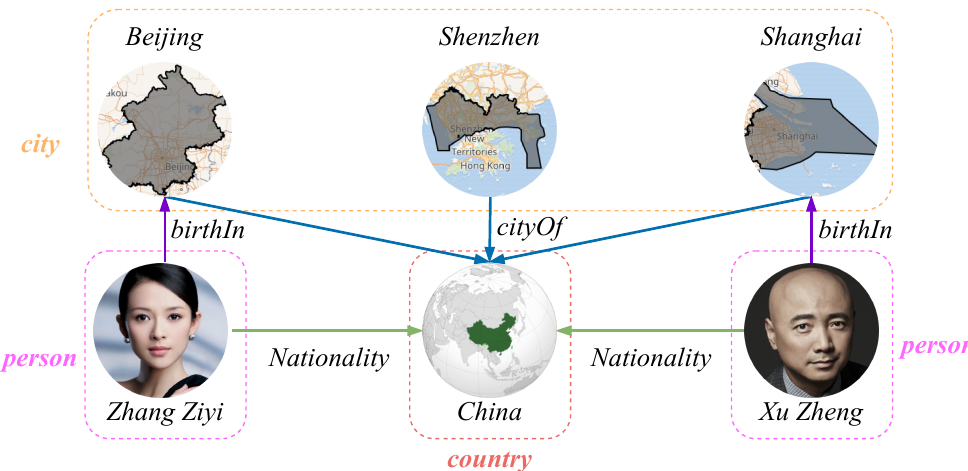
Figure 1. A konwledge graph example with type